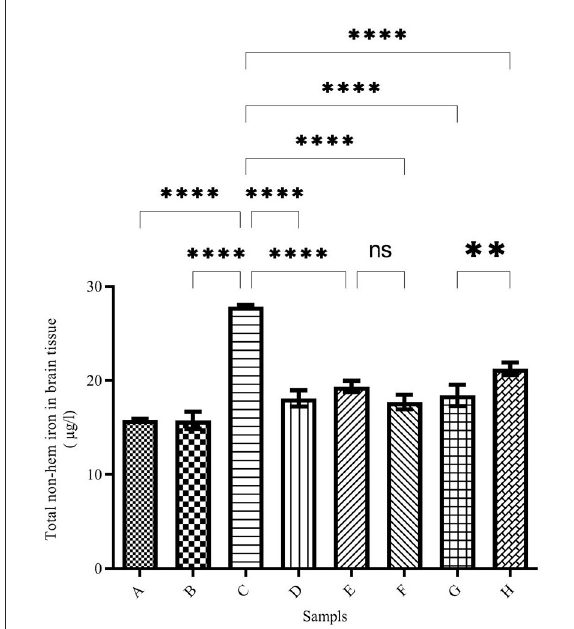
FIGURE2 Brain total non-heme iron content in the treated mice. Group A: control group, normal saline-receiving group; Group B: normal saline and DFO-receiving group; Group C: iron dextran and normal saline-receiving group; Group D: iron dextran and DFO-receiving group; Group E: low dose caffeic acid-receiving group (30 mg/kg/day); Group F: high dose caffeic acid-receiving group (50 mg/kg/day); Group G: low dose ferulic acid-receiving group (30 mg/kg/day); and Group H: high dose ferulic acid-receiving group (50 mg/kg/day) (Mean ± SD; ** p ≤ 0.01 and **** p ≤ 0.0001).